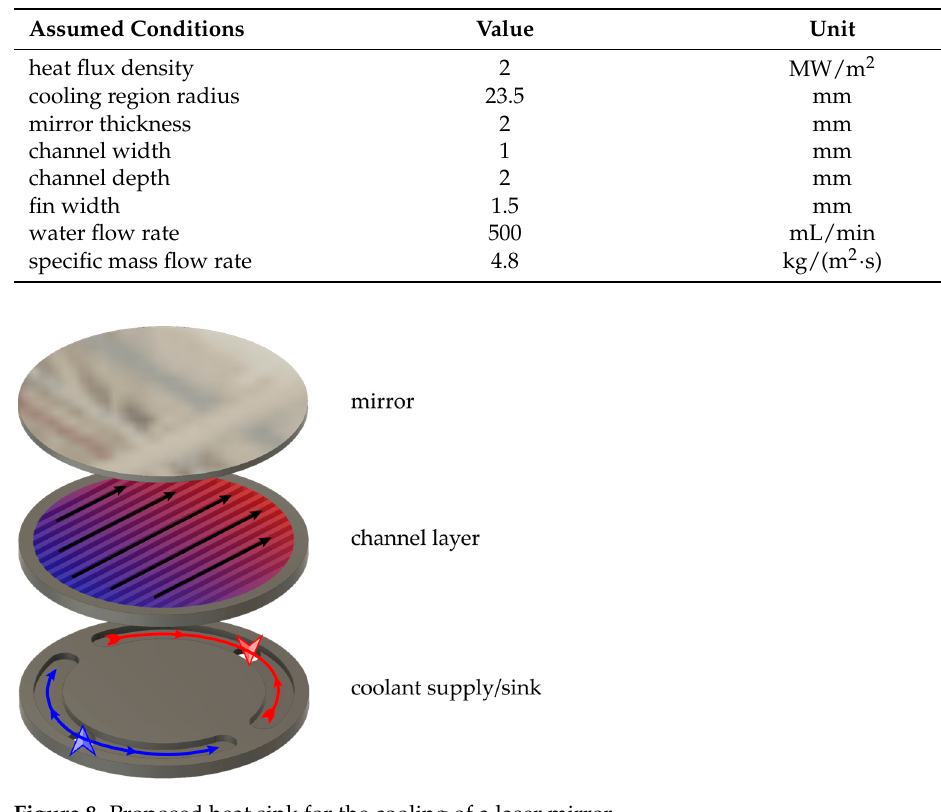
Figure 8. Proposed heat sink for the cooling of a laser mirror.